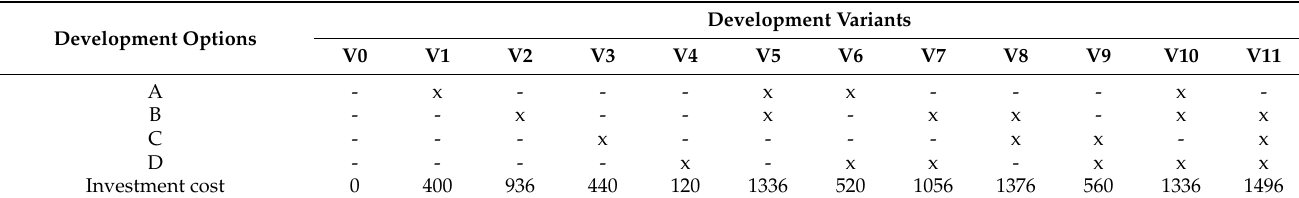
Table 2. List of test network development variants and investment costs, in EUR million. Development